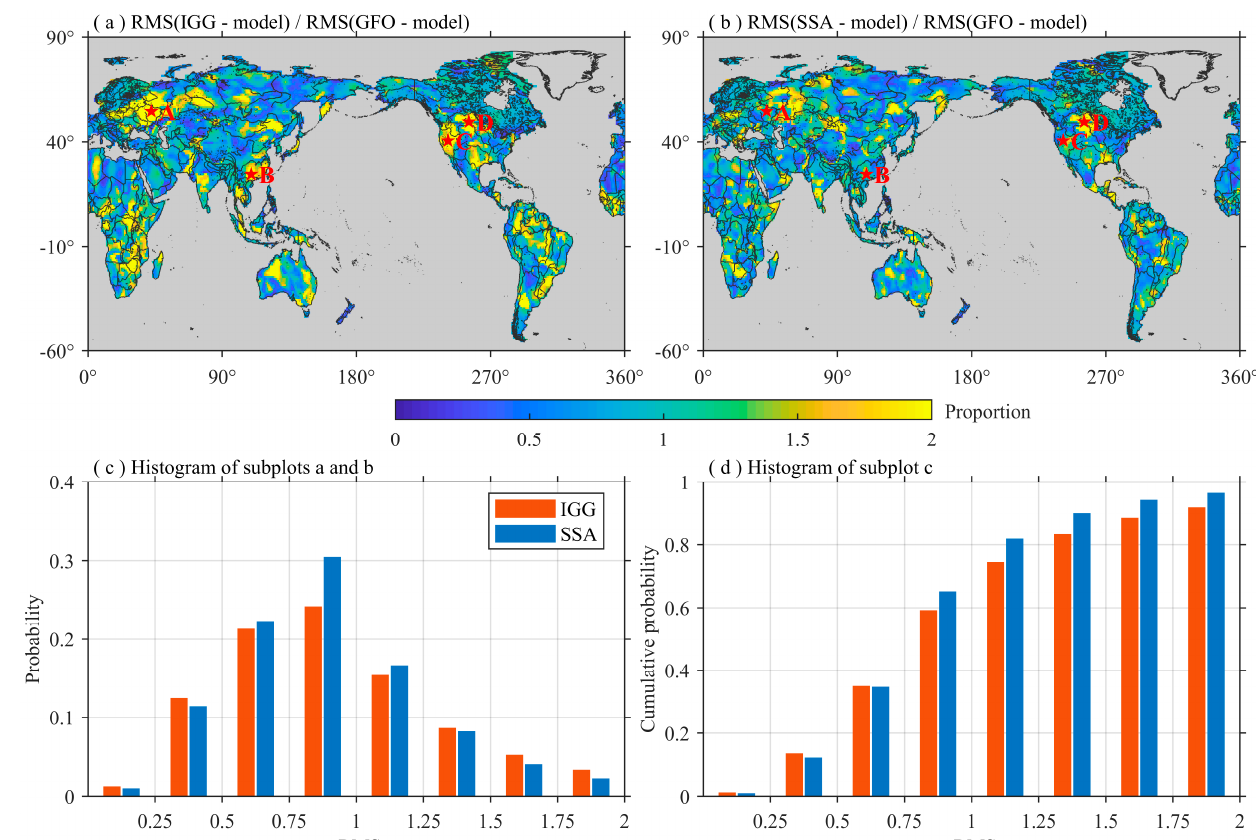
Figure 9. Comparison of the RMS values of residuals of ( a ) IGG and ( b ) SSA by subtracting GRACE- REC. ( c ) Probability and ( d ) cumulative distribution of grid values in ( a ) and ( b ).